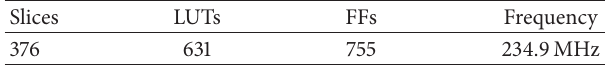
Table 3: Logical resources used by deployment service.